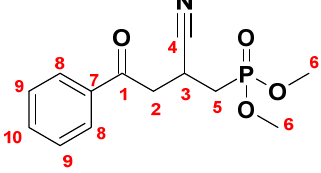
Figure 1. The structure of compound 5a .